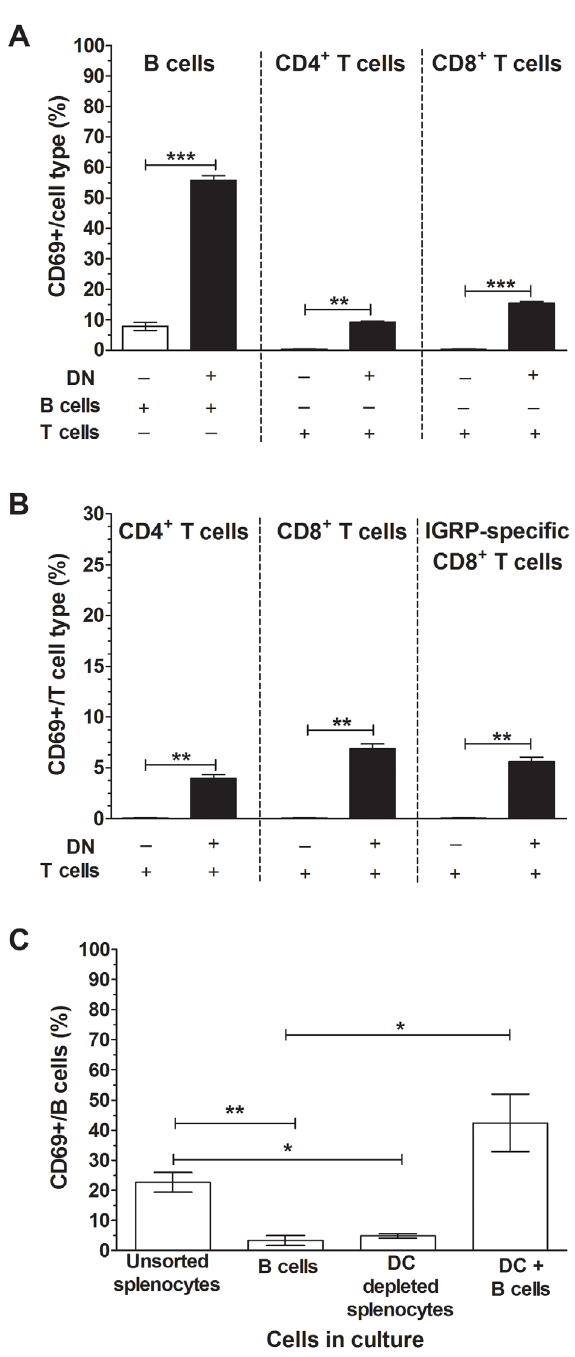
Figure 7. CD11c + DCs were essential for lymphocyte activation by RRV. (A) Sorted DN cells (1 6 10 5 ; CD3 2 CD19 2 ) were cultured in the presence of 100 ng/ml RRV for 24 h with B or T cells (4 6 10 5 ) sorted from NOD splenocytes (black bars). As controls, sorted B cells or T cells alone were stimulated with 100 ng/ml RRV for 24 h (white bars). The proportion of CD69-expressing B cells, CD4 + T cells and CD8 + T cells following stimulation is given, corrected for the proportion of background CD69 expression on unstimulated cells shown in Figure S5A. (B) DN cells (1 6 10 5 ) sorted from NOD splenocytes in the presence of 100 ng/ml RRV for 24 h were cultured with T cells (4 6 10 5 ) sorted from NOD8.3 splenocytes (black bars). As controls, T cells alone were stimulated with 100 ng/ml RRV for 24 h (white bars). The proportion of CD69-expressing CD4 + T cells, CD8 + T cells and IGRP-specific CD8 + T cells following stimulation is given, corrected for the proportion of